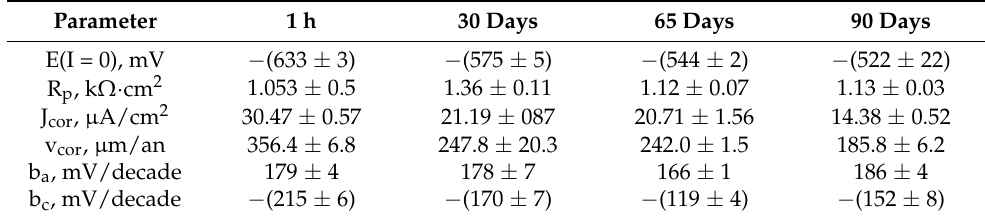
Table 3. Instantaneous corrosion process parameters for samples immersed in DWW-1.